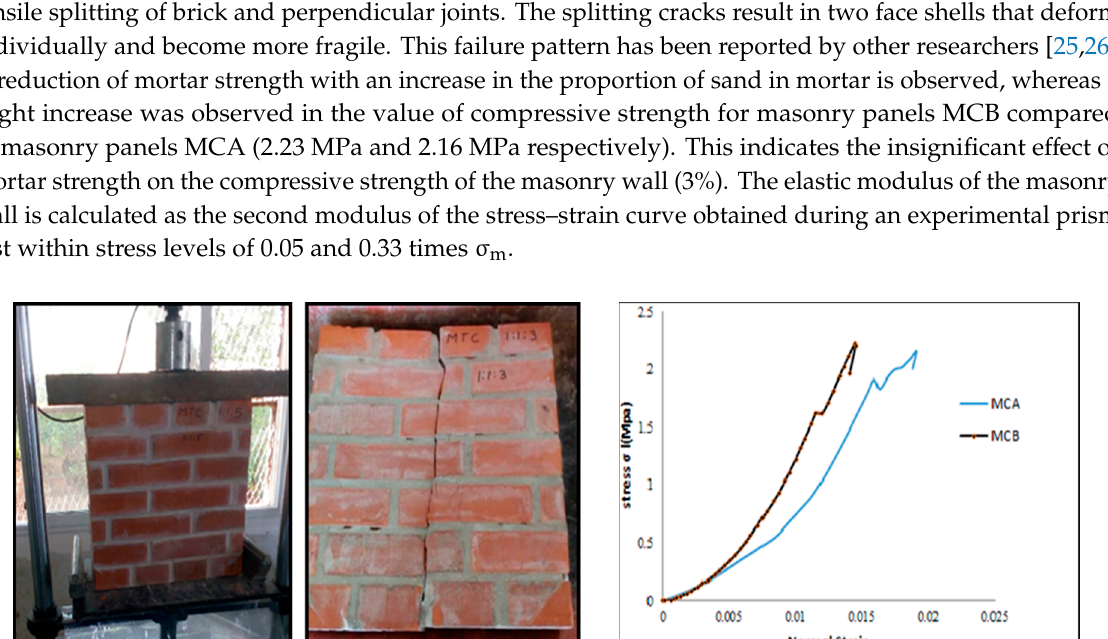
Table 4. Comparison of experimental results Young’s modulus (E) with analytical predictions.